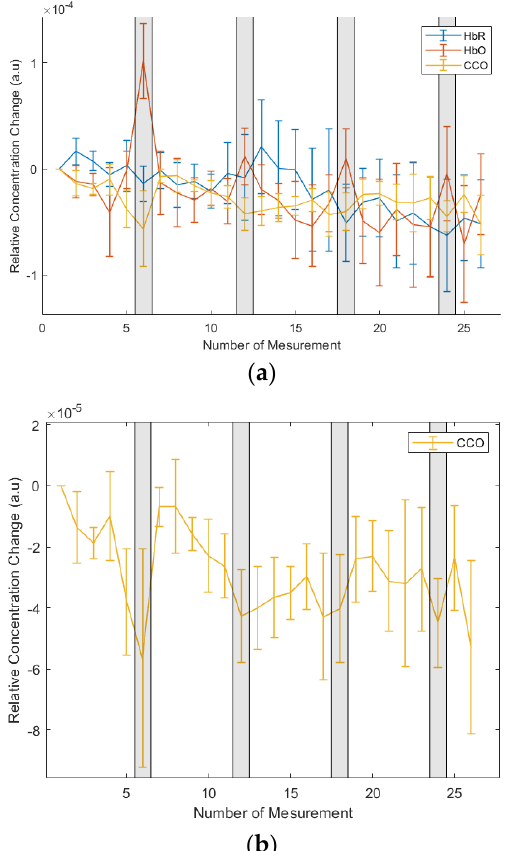
Figure 11. ( a ) Typical measurements of HbO, HbR, and the redox state of CCO using the SCISCCO system in a breath-holding test. ( b ) Expanded view of the changes in redox state of CCO using the SCISCCO system in a breath-holding test. The error bars indicate the variability between each run and between different subjects.